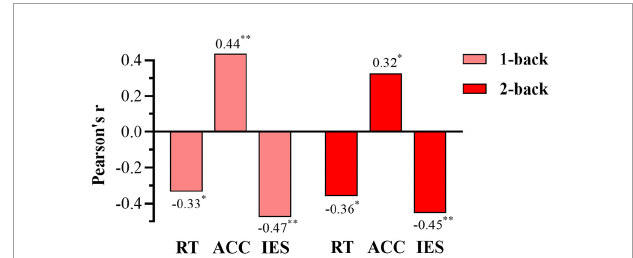
FIGURE6 Bar chart of the correlations between root mean square of successive differences (rMSSD) and behavioral data in the 1-back and 2-back. RT, reaction time; ACC, accuracy; IES, the inverse efficiency score. ∗ The correlation with p -value < 0.05, ∗∗ the correlation with p -value < 0.01.